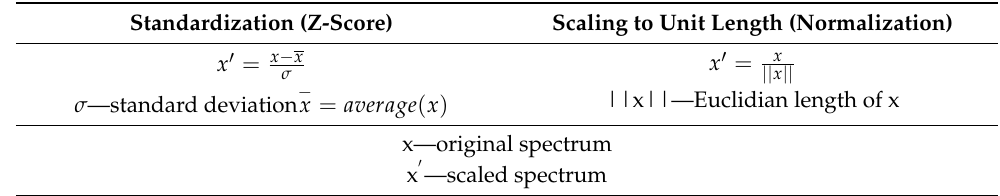
Table 1. Equations for used pre-processing techniques.